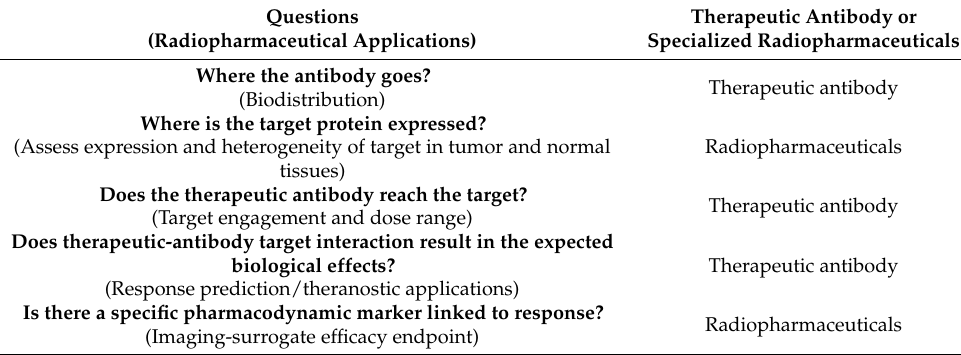
Table 4. The crucial questions for radiopharmaceuticals.